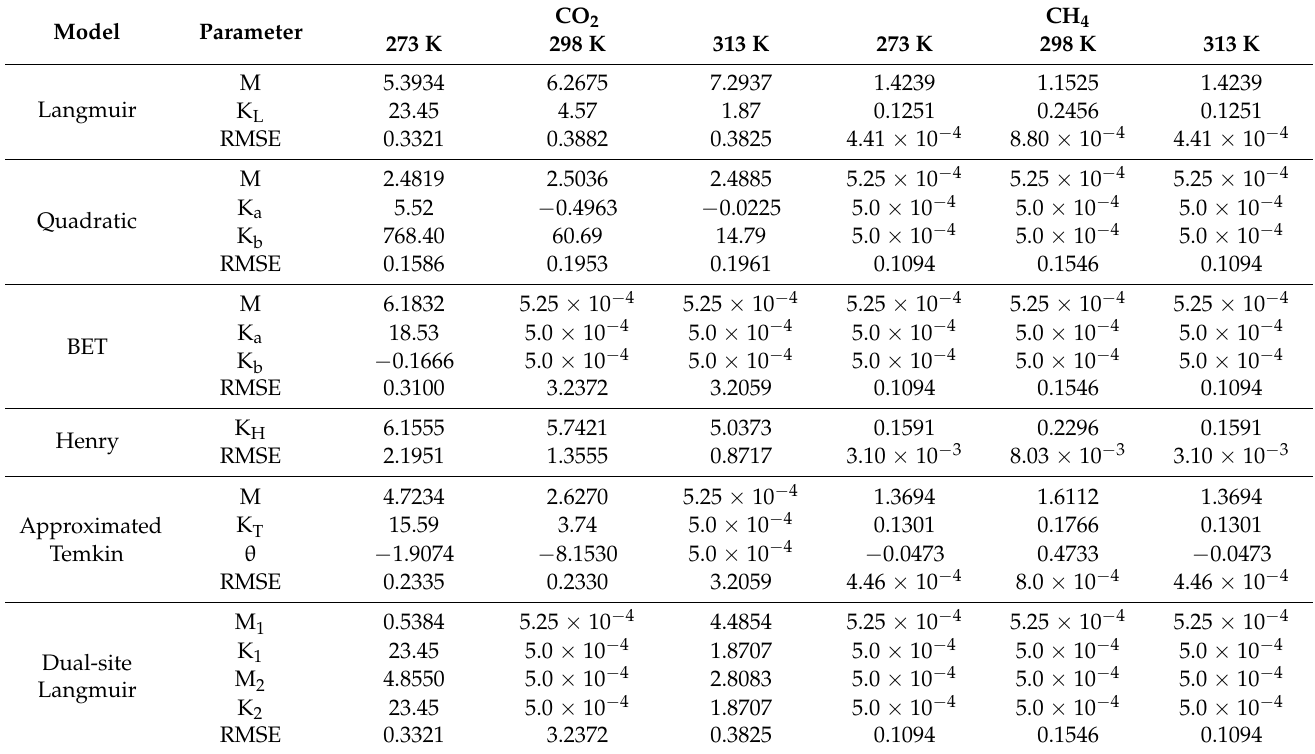
Table 2. Parameter values of isotherm